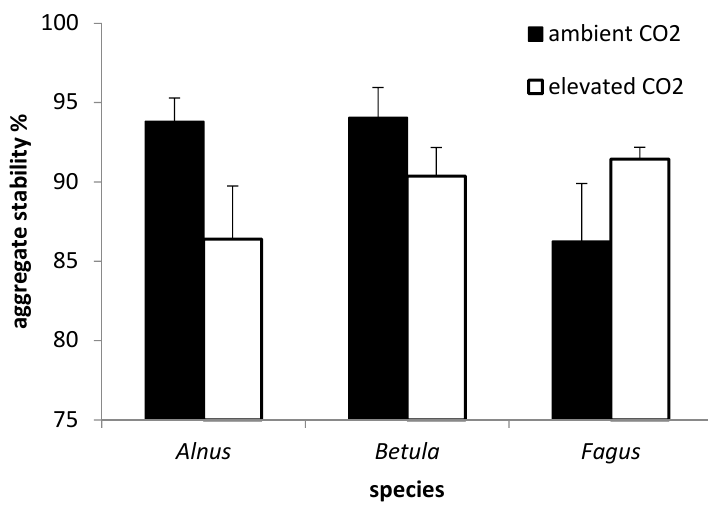
Figure 2. Interaction ( p = 0.046) plot for CO 2 regime and litter species (A. glutinosa , B. pendula and F. sylvatica) for stable aggregation—field experiment. Error bars represent standard errors ( n = 4).